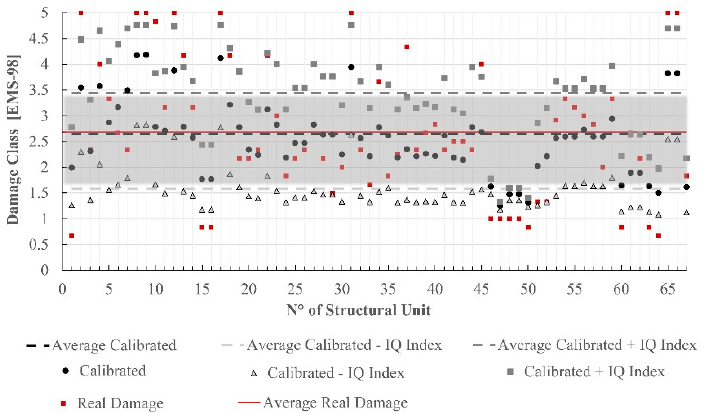
Figure 21. Comparison between real damage and the theoretical damage evaluated through the calibrated method considering the Information Quality (IQ) index. The grey area defines in average the possible damage scenarios of the case study according to the EMS98 scale.